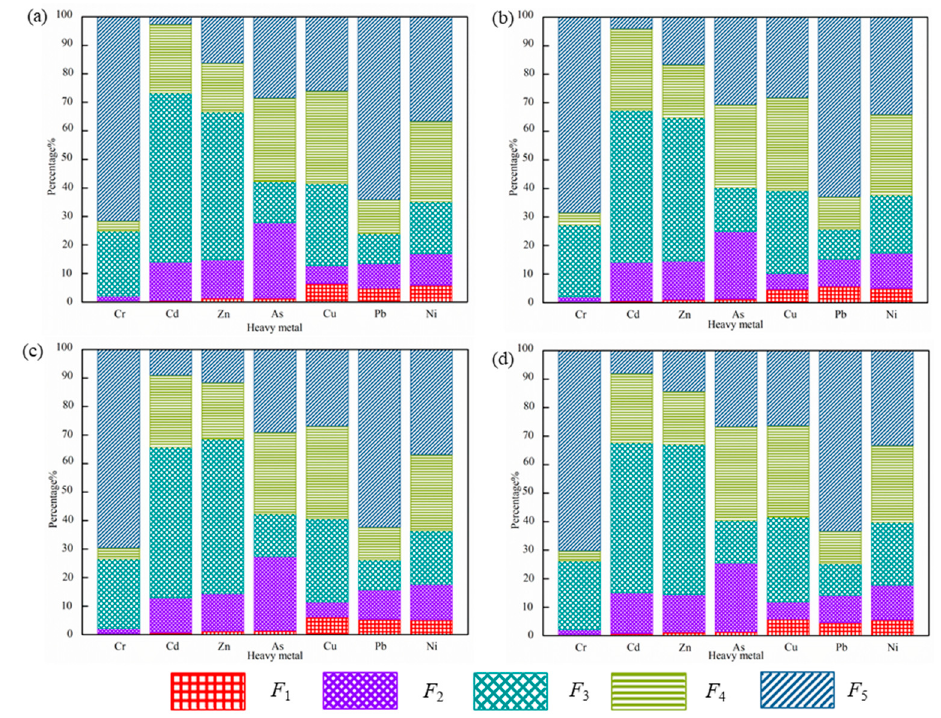
Figure 2. Chemical speciation of heavy metals in ( a ) TJA (Tianjiaan) ( b ) SN (Shannan) ( c ) PJ (Panji) and ( d ) BGS (Bagongshan).